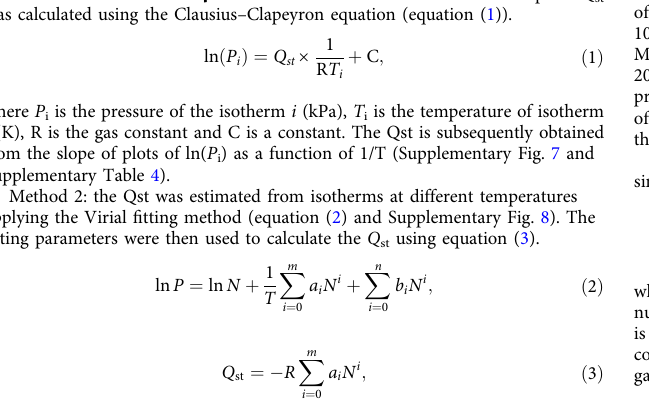
Gas-adsorption . Low-pressure ( < 1bar) adsorption measurements were performed using an Accelerated Surface Area and Porosimetry 2020-M System. Before the measurements, about 100 mg solvent-exchanged samples were loaded into the sample tube and then degassed under dynamic vacuum at 100 °C for 10h to obtain fully desolvated samples. Low-pressure N 2 adsorption isotherms were measured at 77K in a liquid nitrogen bath (Supplementary Fig. 6). Low-pressure CO 2 adsorption isotherms were measured at 195, 273, 283, 288, 291, 293, 298 and 308 K. The speci fi c surface areas were determined using the BET model from the CO 2 adsorption isotherm.